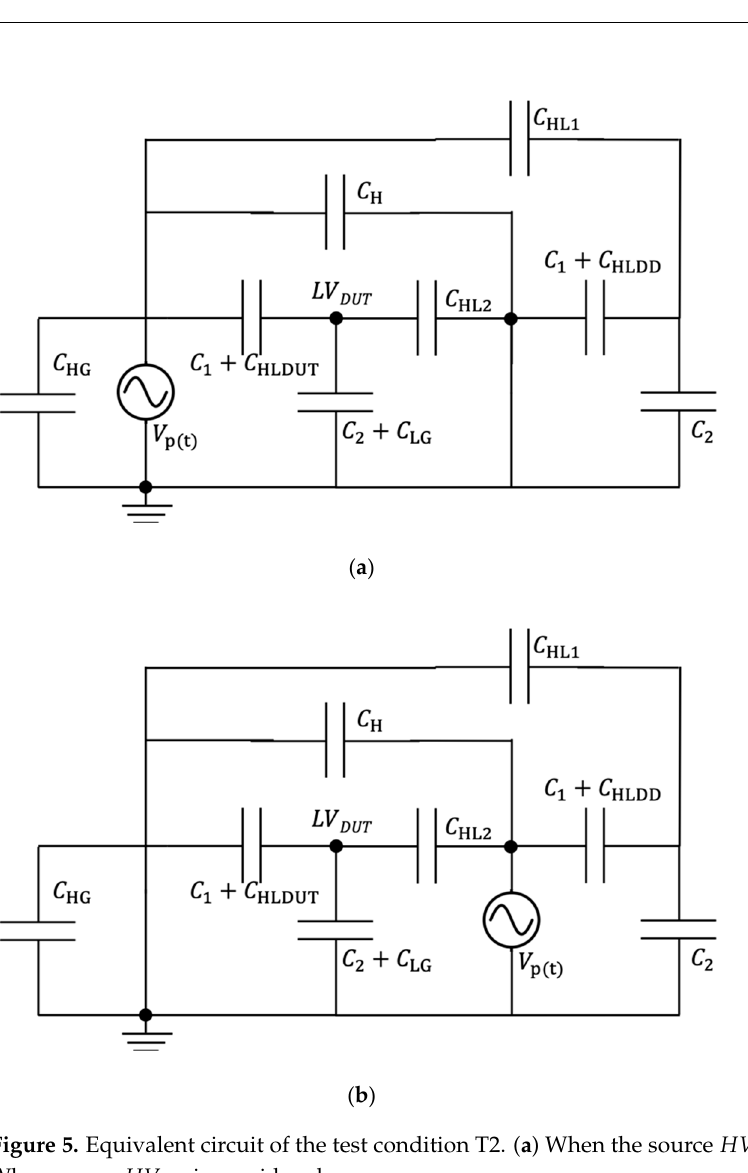
Figure 5. Equivalent circuit of the test condition T2. ( a ) When the source HV DUT is considered; ( b ) When source HV DD is considered.